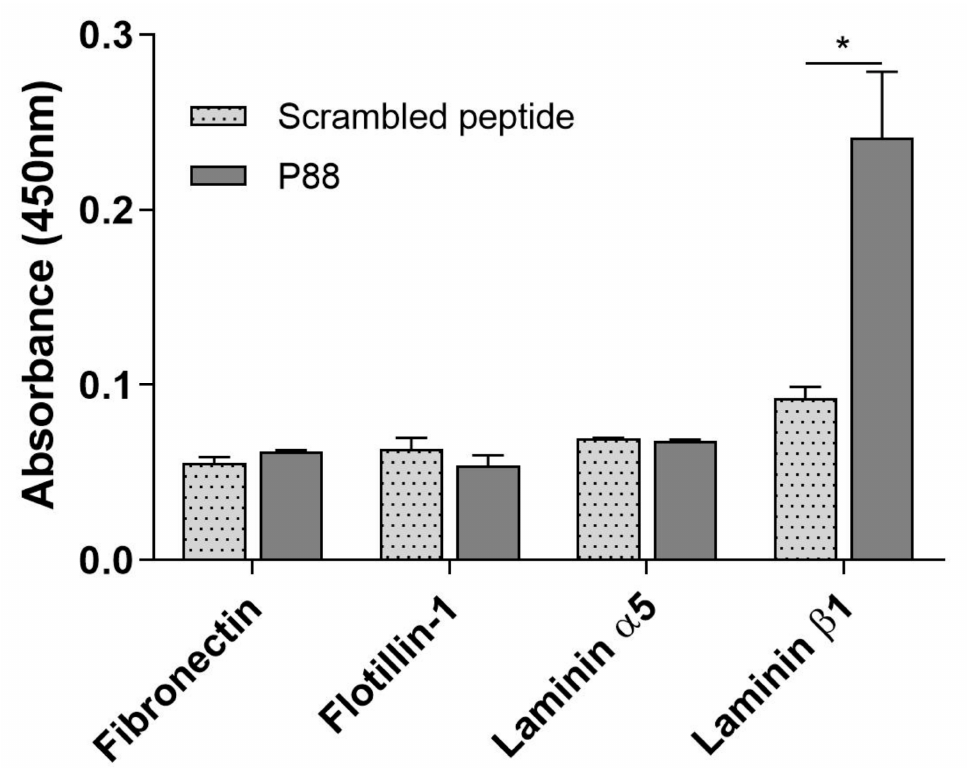
Figure 3. Evaluation of peptide-88 binding to selected human proteins. A solid-phase microplate protein-binding assay was developed to identify the target protein of peptide-88. The scrambled peptide comprises twelve amino acids forming a linear peptide biotinylated at the N-terminal that exhibited no binding to control cells or IL-1 β treated cells. The scrambled peptide and peptide-88 were used at 500 µ g/mL. The absorbance was determined in a microplate reader at 450 nm. A blank was also included for each evaluated protein that consisted of PBS instead of the peptide as an internal control. Statistical differences were determined by Student’s t -test (* p < 0.05, n =